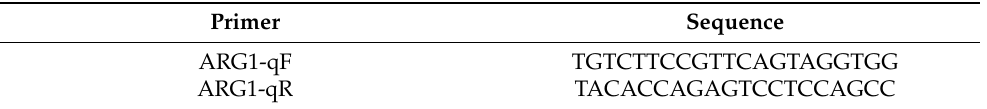
Table 1. Primer information for qPCR. Design primers to detect the transcription of porcine ARG1 gene in PAM cells.